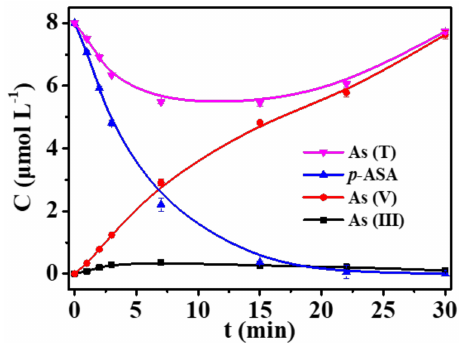
Figure 4. Concentration changes of arsenic species in UV/PS system: (1) As T (As III + As V + p -ASA); (2) p -ASA; (3) As V ; (4) As III . Conditions: ( p -ASA) = 8 µ mol L − 1 , (PS) = 1 mmol L − 1 , (PB) = 20 mmol L − 1 , pH =